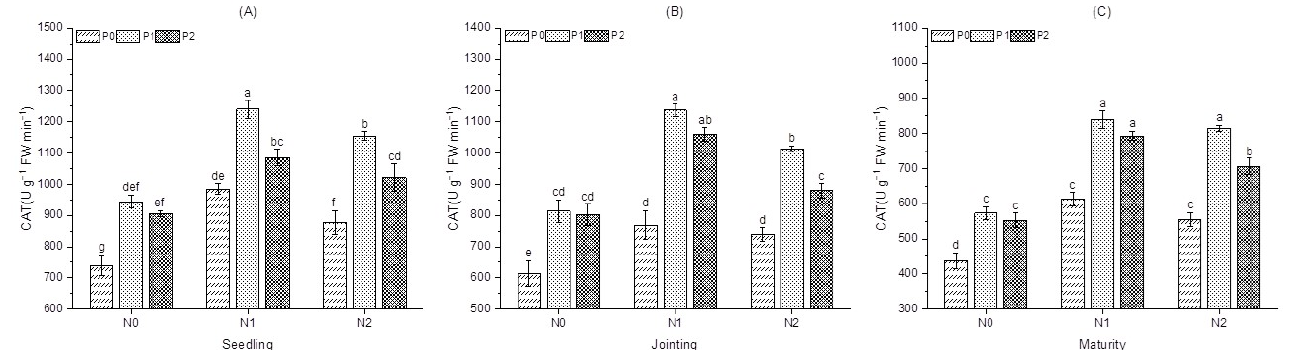
Figure 3. Effects of nitrogen and phosphorus on catalase (CAT) activity of sorghum plants grown in saline soils at the three growing stages of seedling, jointing, and maturity. ( A ) Seedling stage; ( B ) Jointing stage; ( C ) Maturity stage. Within each sampling date, the data followed by different letters are statistically different at the 0.05 probability level.